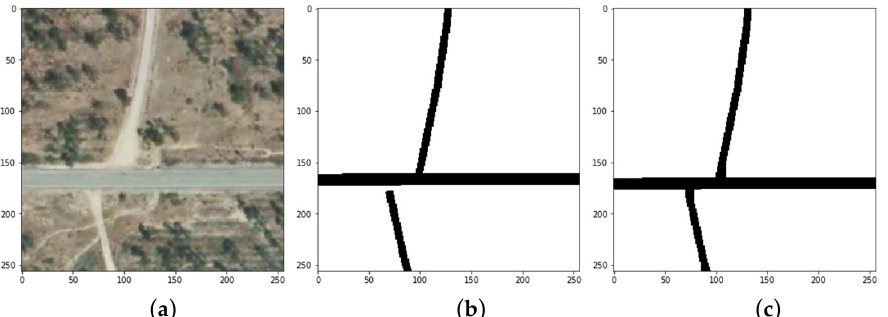
Figure 1. An example of inpainting post-processing with morphology operators based on shapes to fill missing parts ( c ) of the initial segmentation mask predictions ( b ) delivered by the semantic segmentation model after evaluating an unseen aerial orthoimage ( a ).